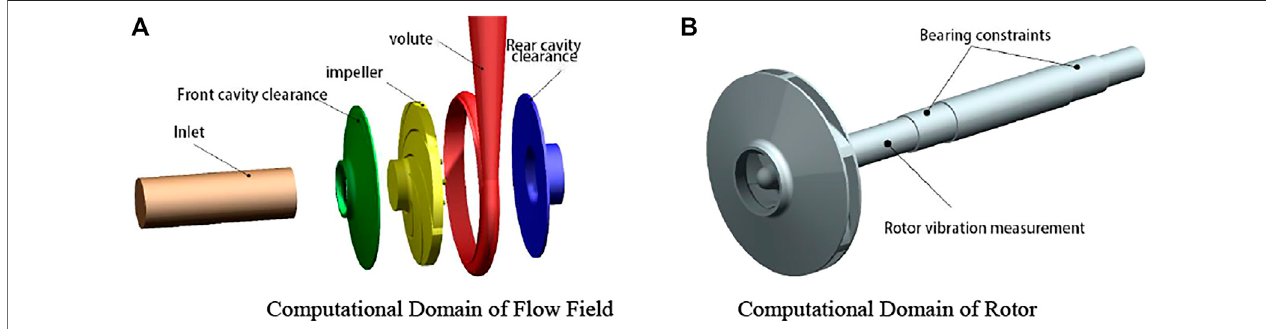
FIGURE 1 | Diagram of computational domain of fl ow fi eld and rotor. (A) Computational domain of fl ow fi eld. (B) Computational domain of rotor.